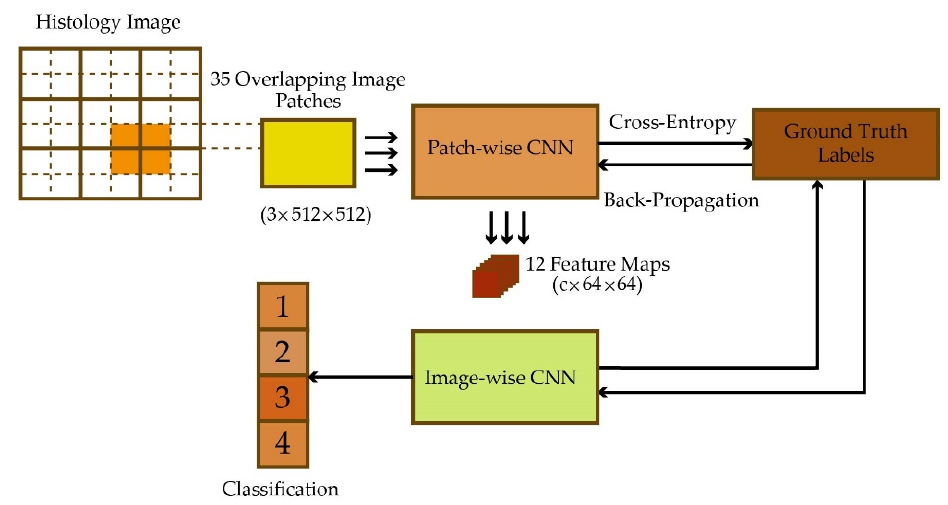
Figure 2. The end-to-end attachment of two networks: 1. Patch-wise CNN, 2. Image-wise CNN.